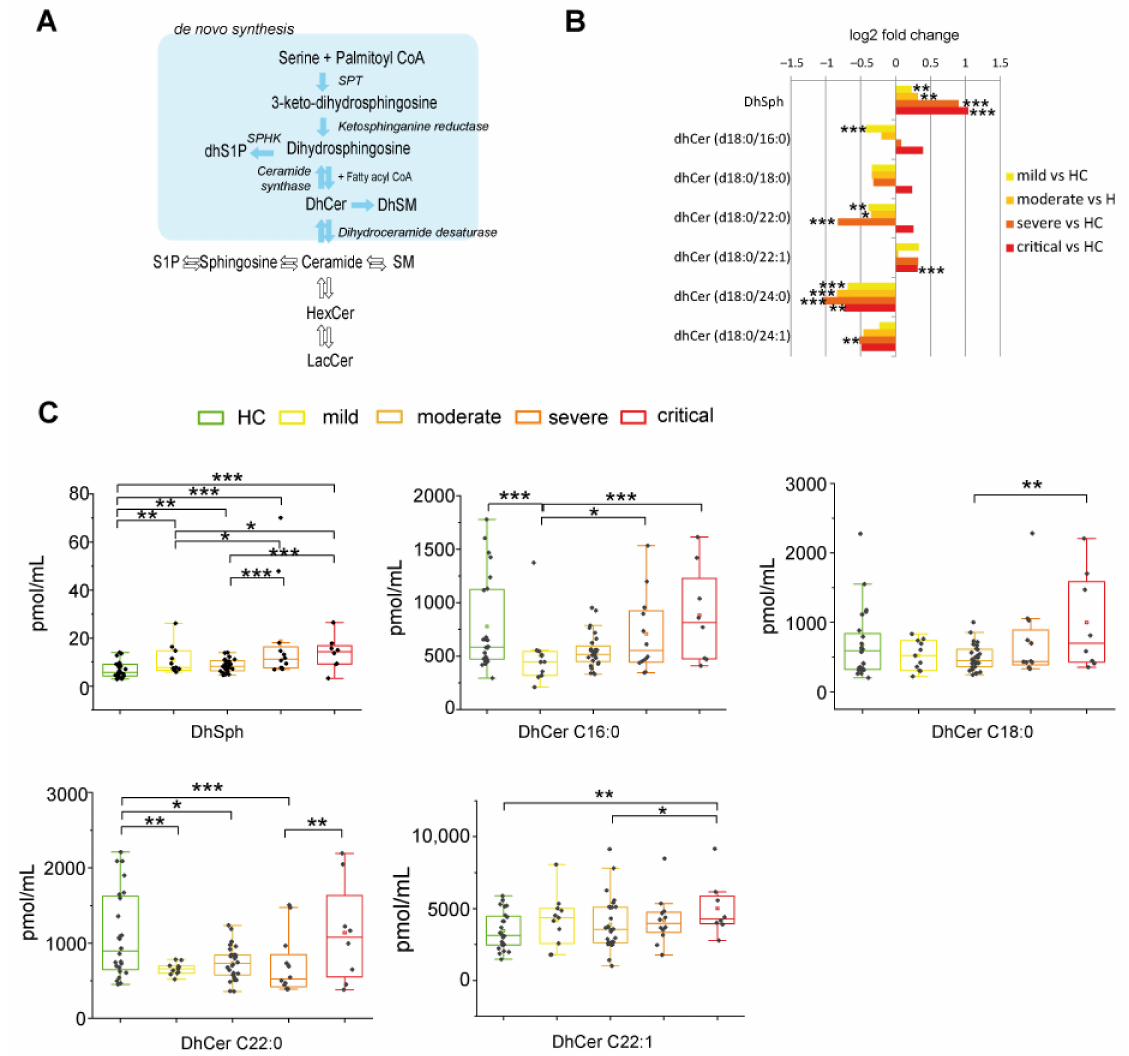
Figure 2. Serum sphingolipid changes related to COVID-19 in de-novo synthesis pathway. ( A ) Close up of de novo synthesis pathway, highlighted in light blue. ( B ) Log 2 fold changes in the median values of DhSph and DhCers in COVID-19 severity groups vs. healthy controls (HC). ( C ) Box plots of DhSph, DhCer C16:0, DhCer C18:0, DhCer C22:0, and DhCer C22:1 serum levels, according to COVID-19 severity. Box plots and whiskers represent the interquartile range with median value (central line) and the lowest and largest data point measured, respectively. Each measurement was performed in triplicate. Data were analyzed using Kruskal-Wallis ANOVA, followed by Dunn’s post hoc test for multiple comparisons. * p -value < 0.05, ** p -value < 0.01, *** p -value <